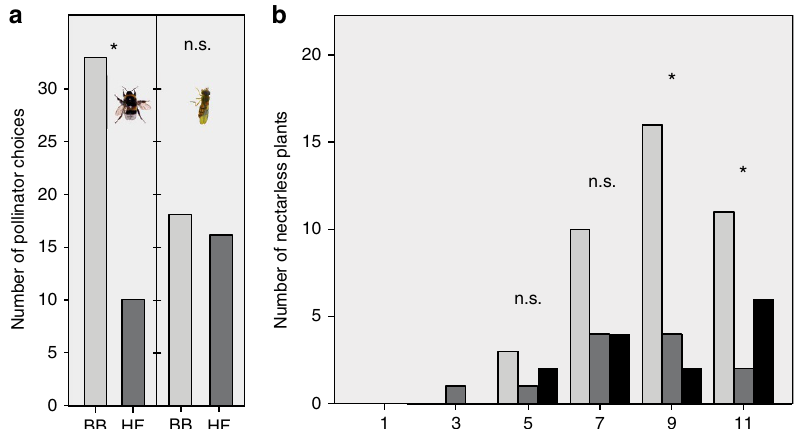
Figure 3 | Pollinator preferences and evolution of nectarless plants. ( a ) First choices of bumblebees (left pair of bars, n ¼ 43) and hoverflies (right pair of bars, n ¼ 34) when allowed to choose between bumblebee- (BB) and hoverfly-pollinated plants (HF) of generation 11. Bumblebees preferred bumblebee-pollinated plants (binomial test, P ¼ 0.001), which shows that those plants have adapted to bumblebee preferences. Hoverflies showed no preferences ( P ¼ 0.864). ( b ) Number of nectarless plants in bumblebee- (light grey) hoverfly- (dark grey) and hand-pollinated plants (black) in generations 1–11. The number of nectarless plants was significantly different in generation 9 (generalized linear model with bimodal distribution, w 2 1 ¼ 13.41, P ¼ 0.001) and 11 ( w 2 1 ¼ 6.11, P ¼ 0.047). Photos by the however, nectarless plants had fewer open flowers, reduced petal width, less methyl benzoate and indole, but more ( Z )-3-hexenyl acetate and 2-amino benzaldehyde (GLM P o 0.05).